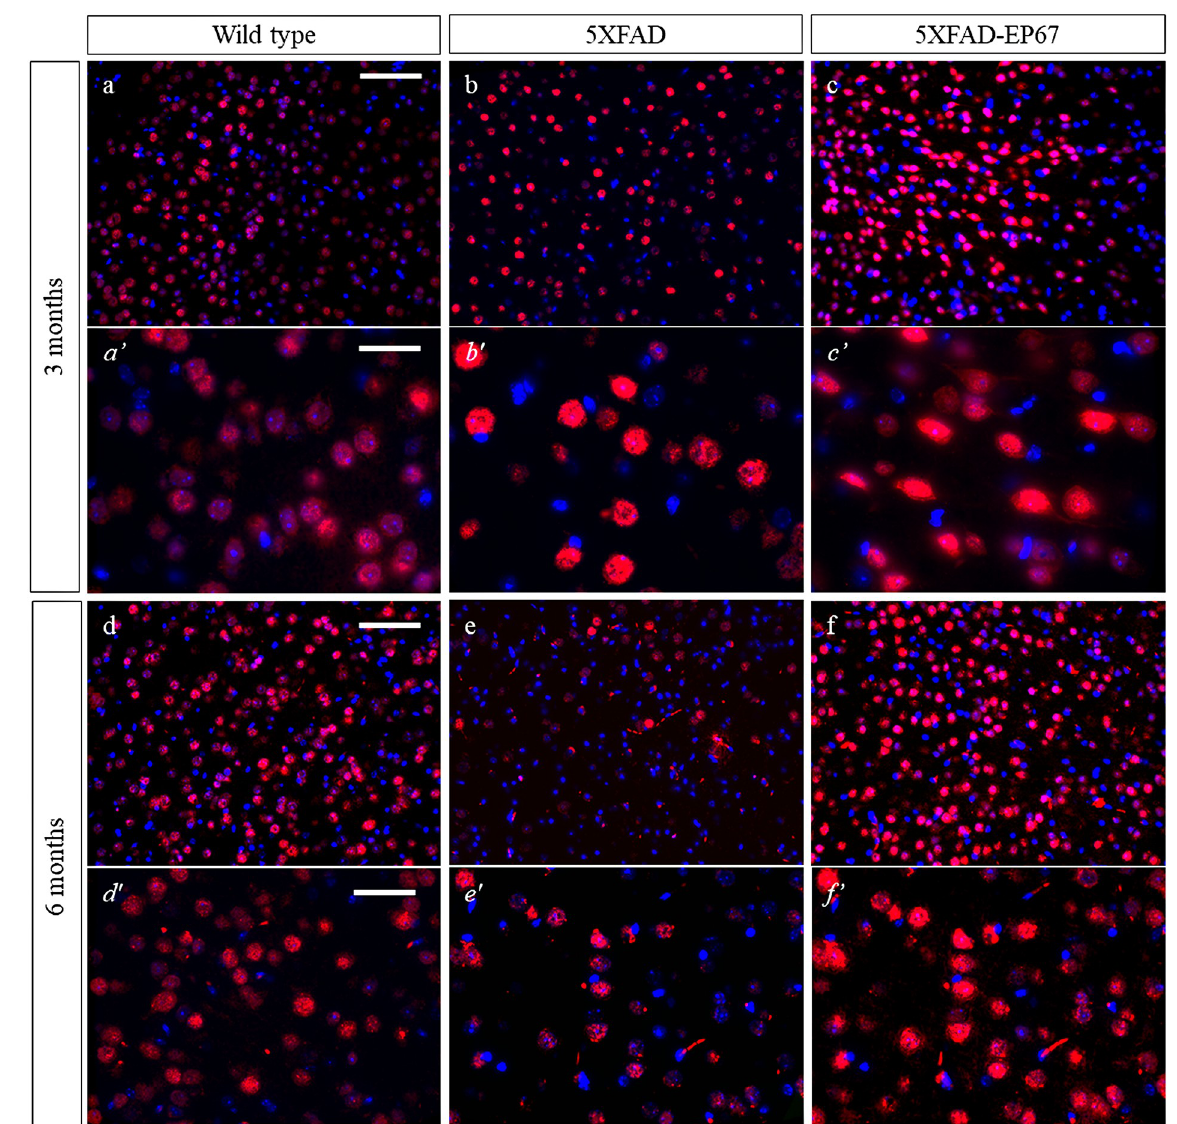
Fig 8. NeuN expression. Representative sagittal cortex sections from 3 and 6 month old wild type (a, a’ & d, d’ ), 5XFAD (b, b’ & e, e’ ) and 5XFAD EP67 treated (c, c’ & f, f’ ) mice sections were co-stained with an antibody against NeuN (-red- excitation λ : 358 emission λ :461) and DAPI nuclear staining (-blue- excitation λ : 555 emission λ :580). Scale bars: a-c & d-f 150 μ m, a’- c’ 75 μ m and d’-f’ 48 μ m.